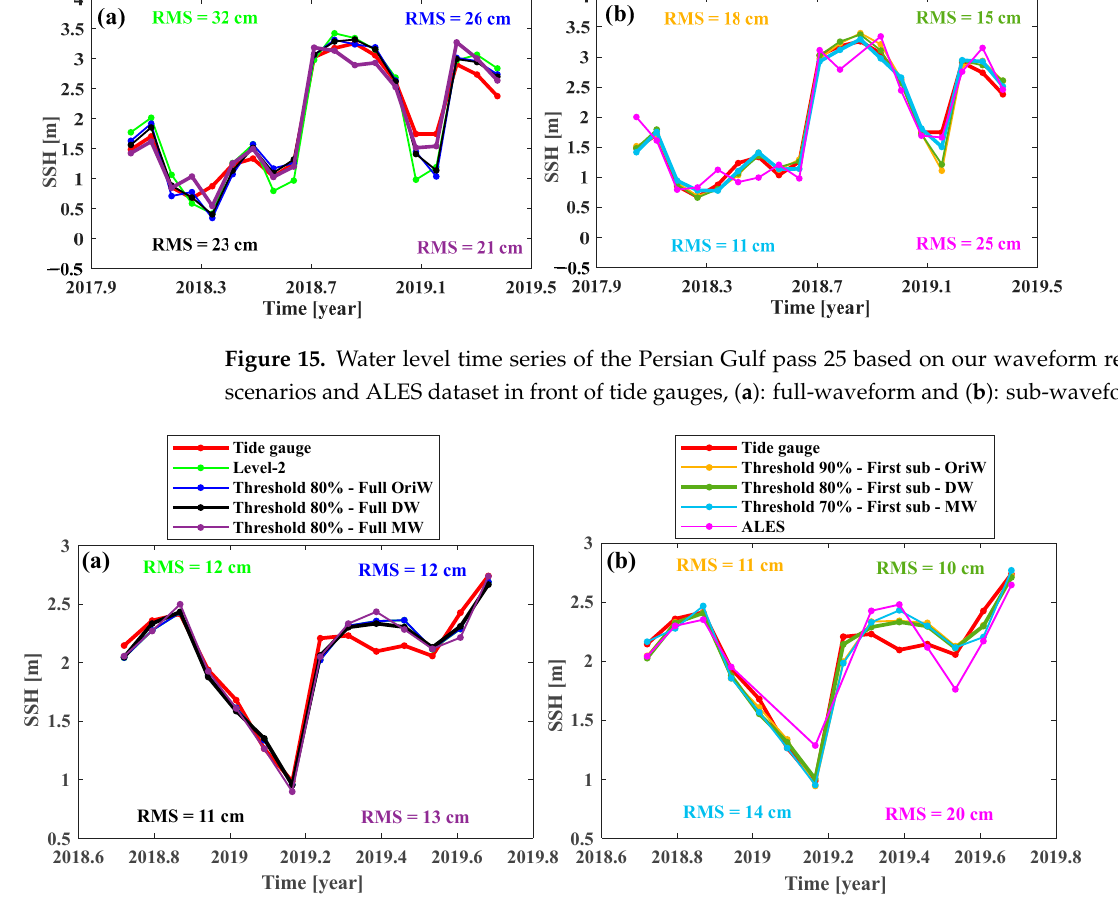
Figure 16. Water level time series of the Persian Gulf pass 139 based on our waveform retracking scenarios and ALES dataset in front of tide gauges, ( a ): full-waveform and ( b ): sub-waveform.